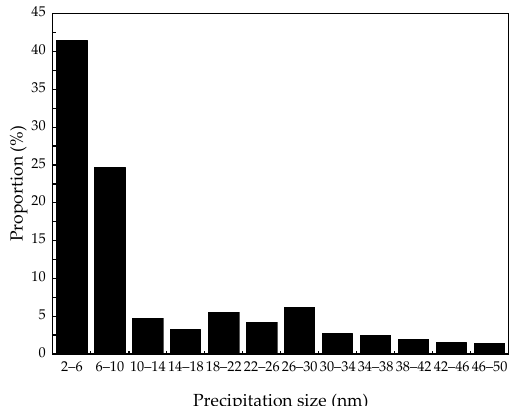
Figure 4. Size distribution of V(C, N) precipitates in the base material of the 10 V steel.